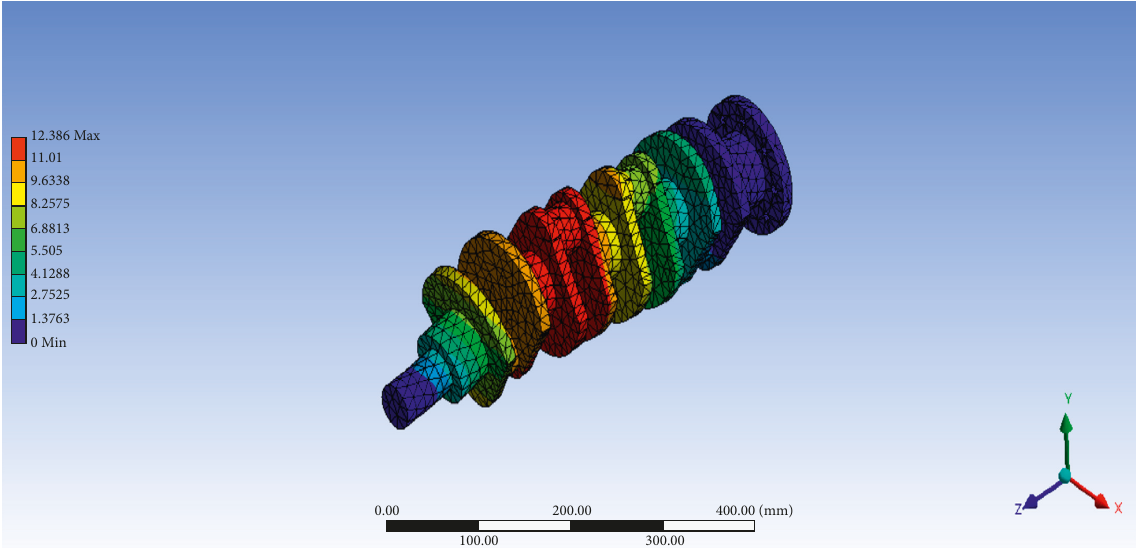
Figure 11: Deformation of carbon fiber composite crankshaft at the first mode of